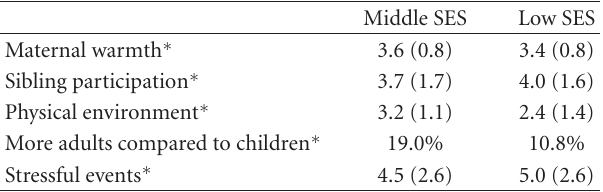
Table 3: Social factors by SES